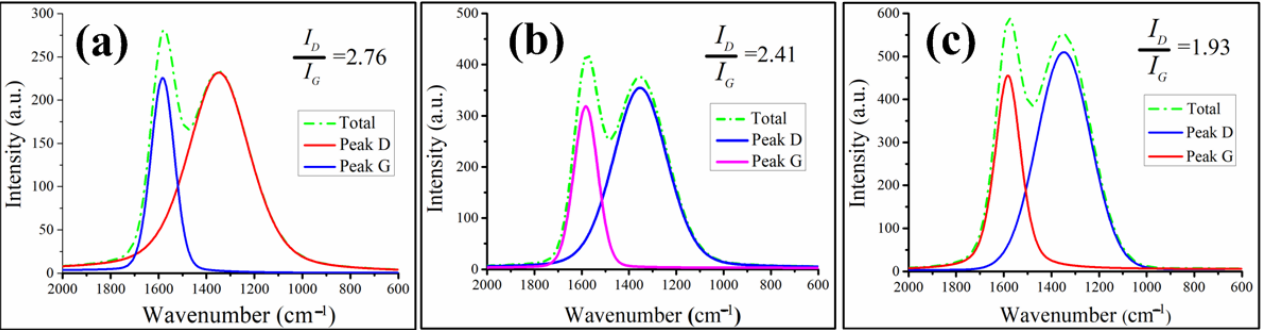
Figure 6. Raman spectra of char residues: (a) EP, (b) E-HS-10 and (c) E-HS-20.